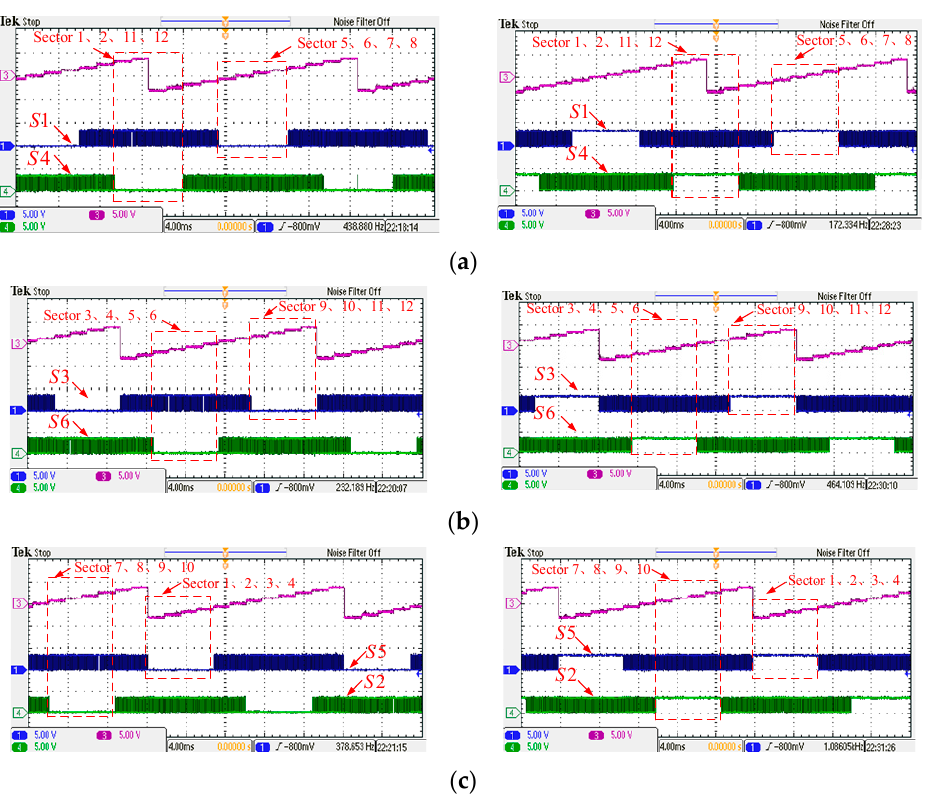
Figure 10. Switch drive waveform ( a ) Switch S1, S4. ( b ) Switch S3, S6. ( c ) Switch S2, S5. (Left: without overlap-time suppression scheme; right: proposed scheme).